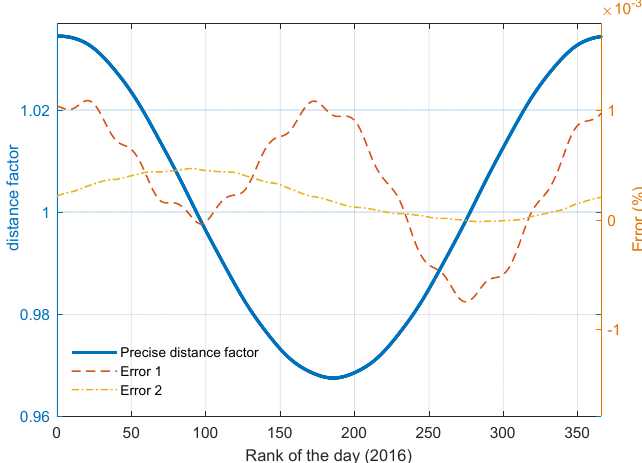
Figure 9. Comparison between Equations (23) and (24) and IMMCE calculation to choose the Earth-Sun distance correction factor.